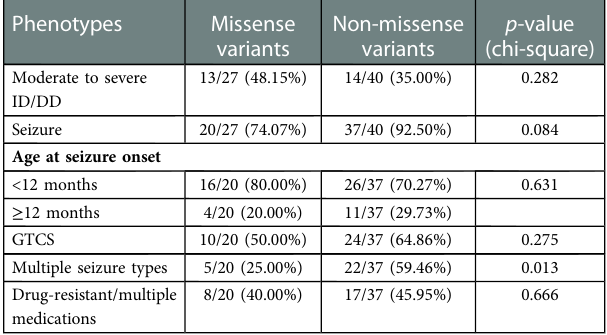
TABLE 2 Comparison of effects of variant type on clinical